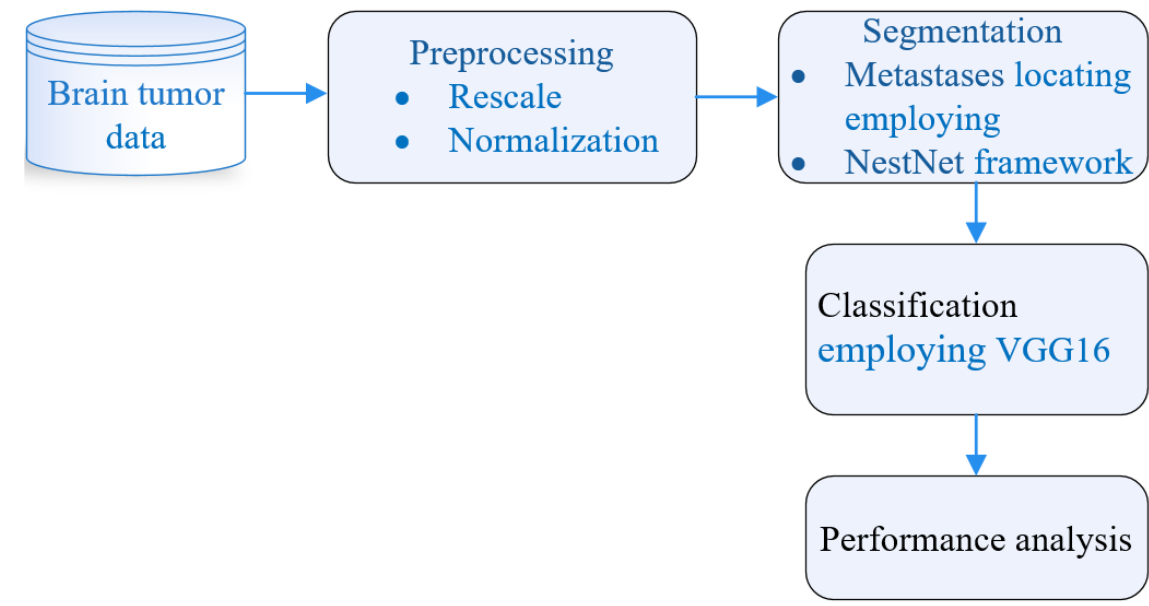
Figure 1. Comprehensive framework for BM classification.